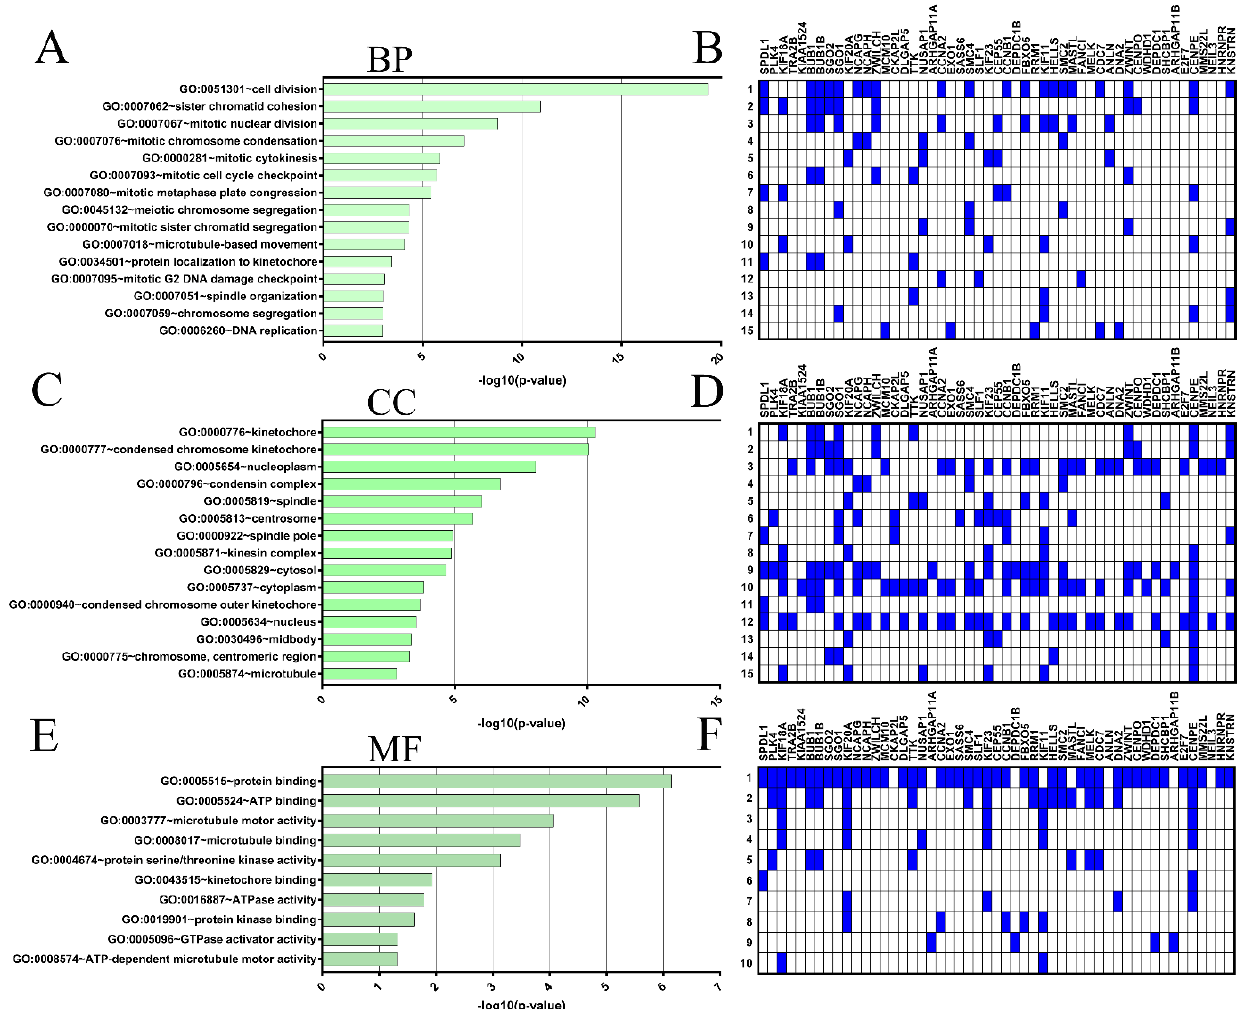
Figure 5. Gene ontology (GO) enrichment analysis for the top 50 genes positively correlated with SPDL1 in CRC. The three GO categories [cellular component (CC), biological process (BP) and molecular function MF)] were detected using DAVID Bioinformatics Tool. The top 15 enriched terms for BP ( A ) and CC ( C ), as well as 10 terms for MF ( E ) are displayed. ( A , C , E ) The horizontal axis of bar chart represents the –log10 ( p ‐ value) for the GO terms represented on the vertical axis. ( B , D , F ) Heatmaps based on the target genes.